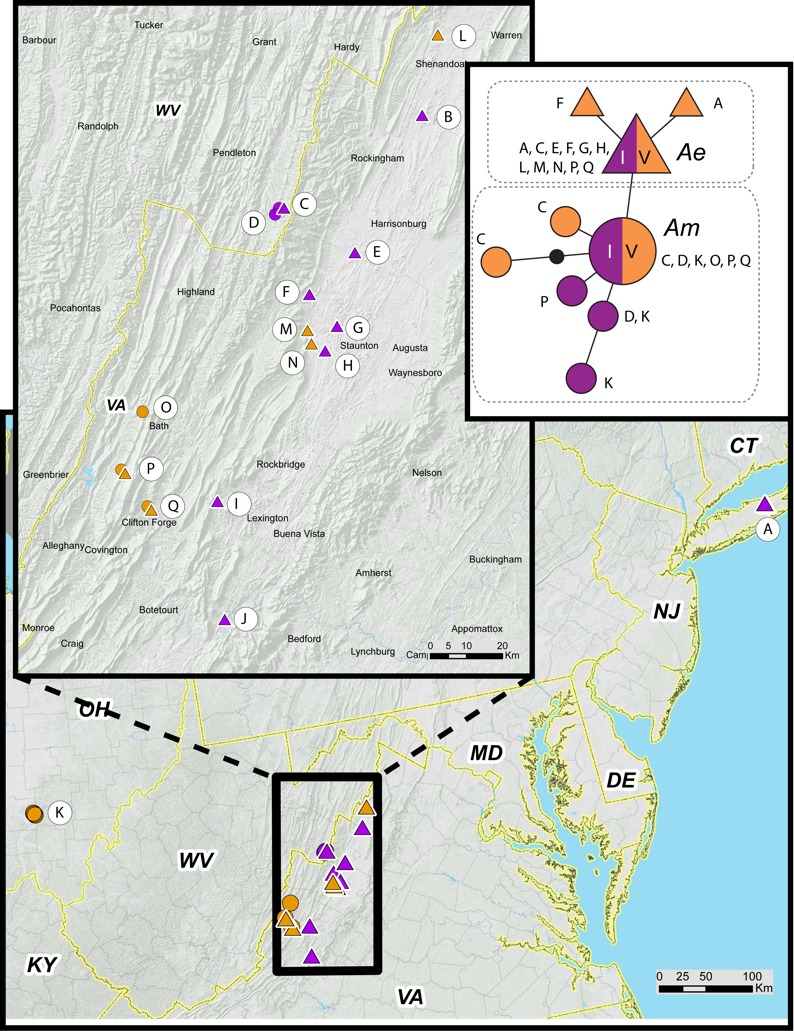
Periodical cicada mtDNA haplotypes in Broods I and V.Haplotype Ae (triangles) and Am (circles) are found in 17-year periodical cicada Broods V (orange symbols) and I (purple symbols) following terminology of Sota et al. (2013). Genetic data from Table 1; haplotype network constructed using TCS version 1.21 (Clement, Posada & Crandall, 2000).